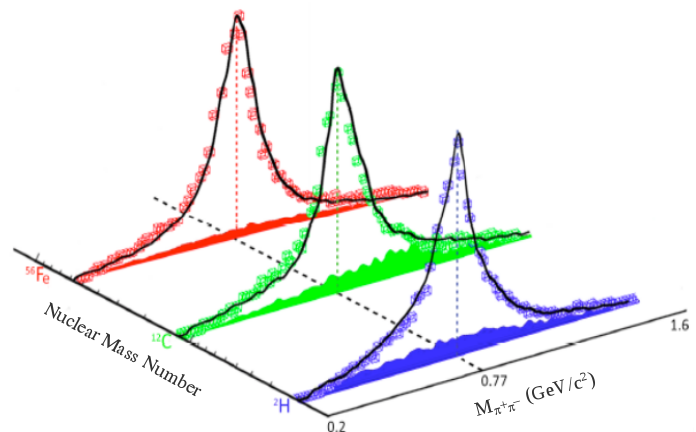
Figure 6. The three-dimensional illustration of ( π + , π − ) invariant mass extracted from our 5 GeV CT data [40] showing the total contribution of the three background processes, ∆ ++ , ∆ 0 and the phase space, as a shaded area in the bottom. The peak positions and widths of the ρ 0 meson agree with the Particle Data Group values for all targets. The solid lines are obtained from our event generator